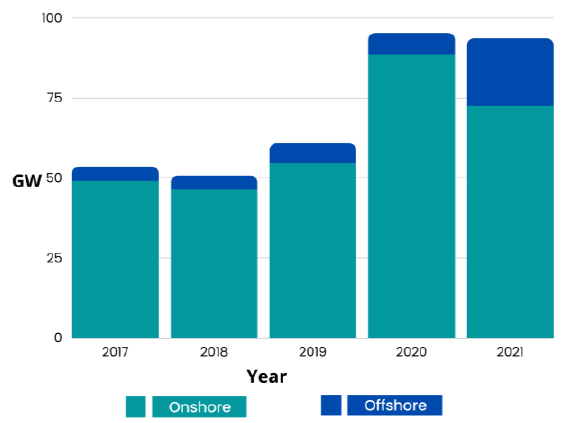
Figure 1. Growth of wind power capacity over the last decade by region. Source: [7].